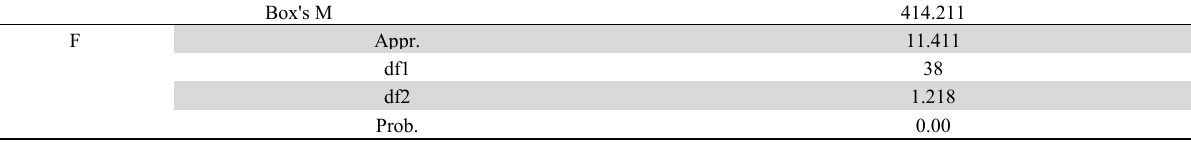
Results of Box's M